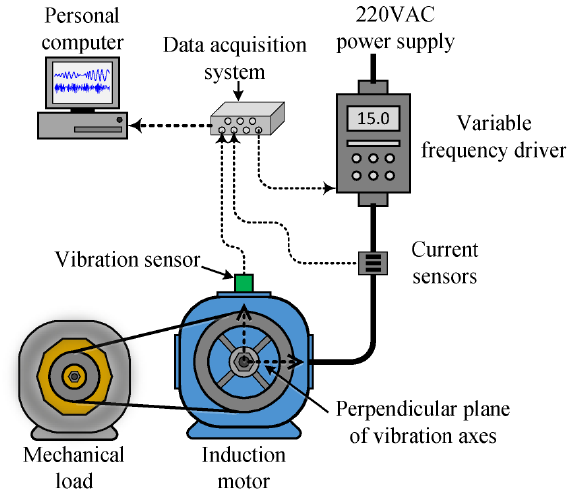
Figure 4. Flow chart of the laboratory electromechanical system based on a pulley-belt system and its wiring to perform the data acquisition.